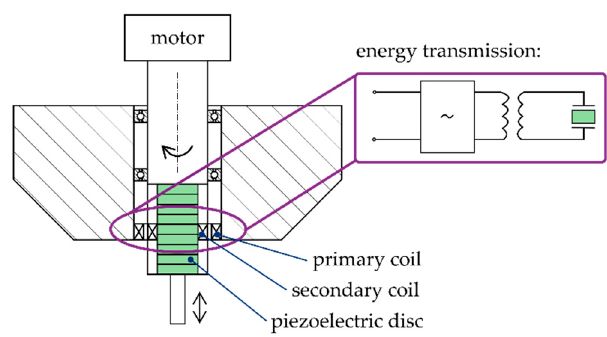
Figure 1. Principle design of a piezoelectric system for ultrasonic assisted milling.